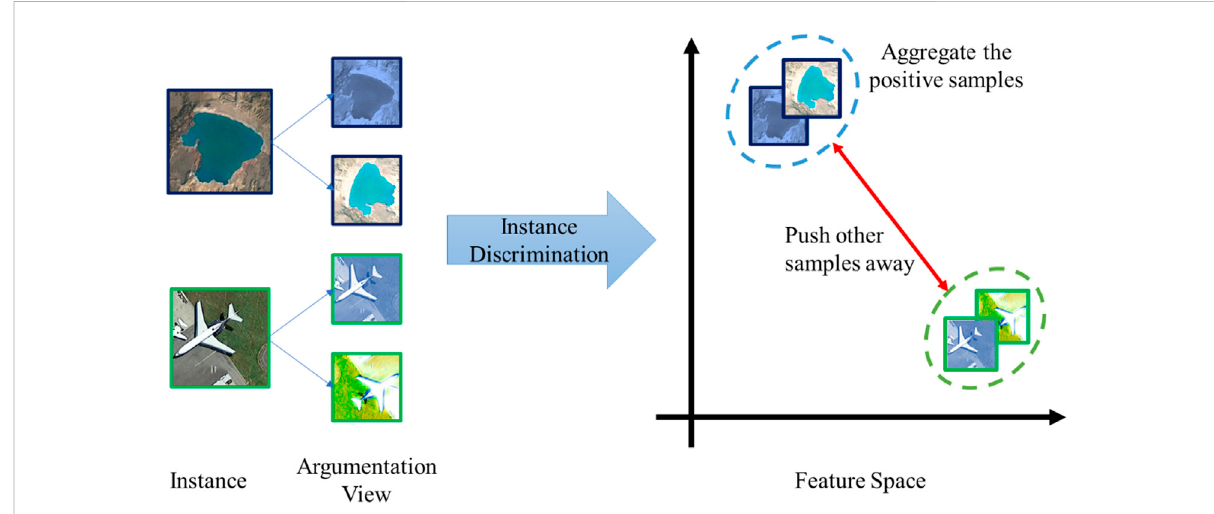
FIGURE 3 Understanding the instance discrimination task from the perspective of feature space.